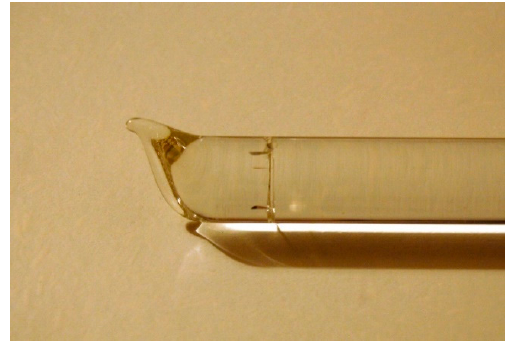
Figure 7. A ship nose with stress cracks (found in 2018).